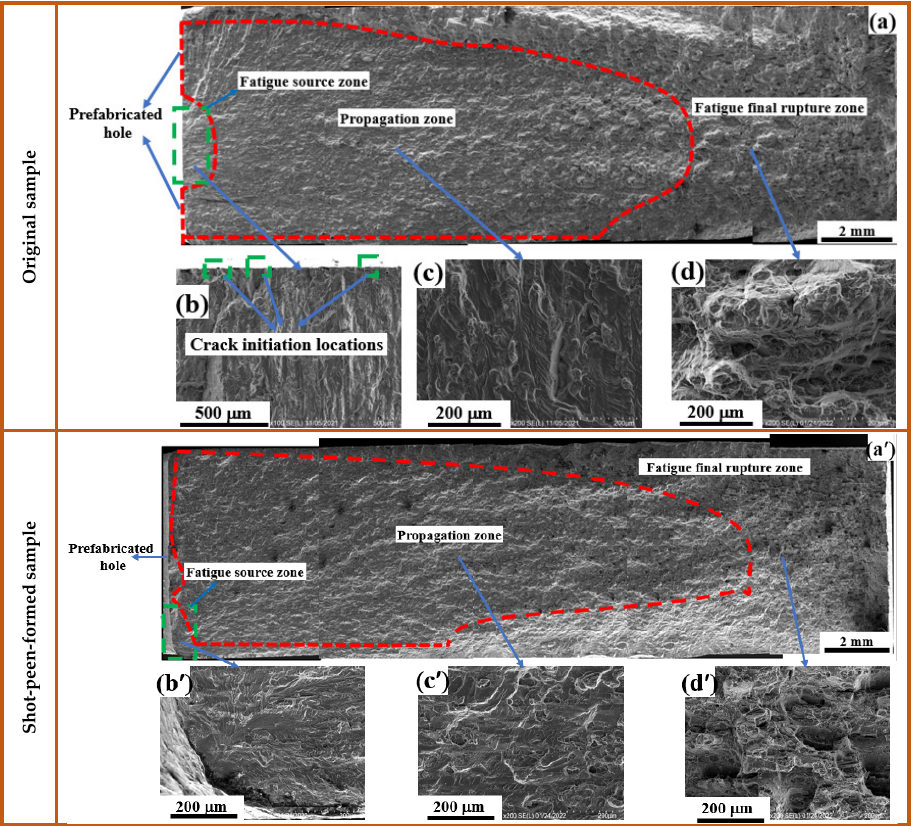
Figure 5. Fatigue fracture morphology of the ( a – d ) original and ( a ′ – d ′ ) shot-peen-formed samples in an atmospheric environment.